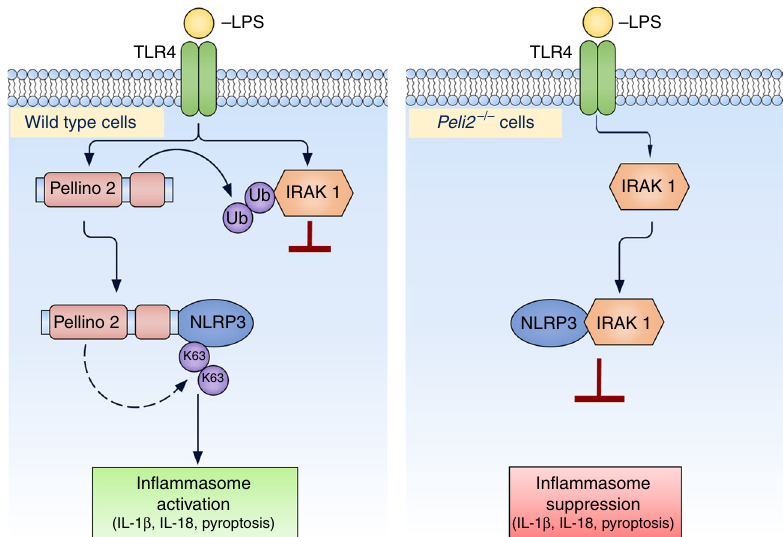
Fig. 9 Schematic representation of Pellino2 mediated NLRP3 in fl ammasome priming. In wild type macrophages LPS promotes the association of Pellino2 with NLRP3 and so facilitates ubiquitination of NLRP3. This promotes NLRP3 in fl ammasome assembly, ASC oligomerization and downstream caspase-1- mediated processing of pro-IL-1 β and pro-IL-18 and pyroptosis. Pellino2 also promotes ubiquitination of IRAK1 and so limits the interaction of IRAK1 with NLRP3 and prevents the inhibitory effects of IRAK1 on NLRP3 activation. In Peli2 − / − macrophages this braking effect of Pellino2 on IRAK1 is removed, allowing for IRAK1 to interact with NLRP3 and suppress downstream activation of the NLRP3 in fl